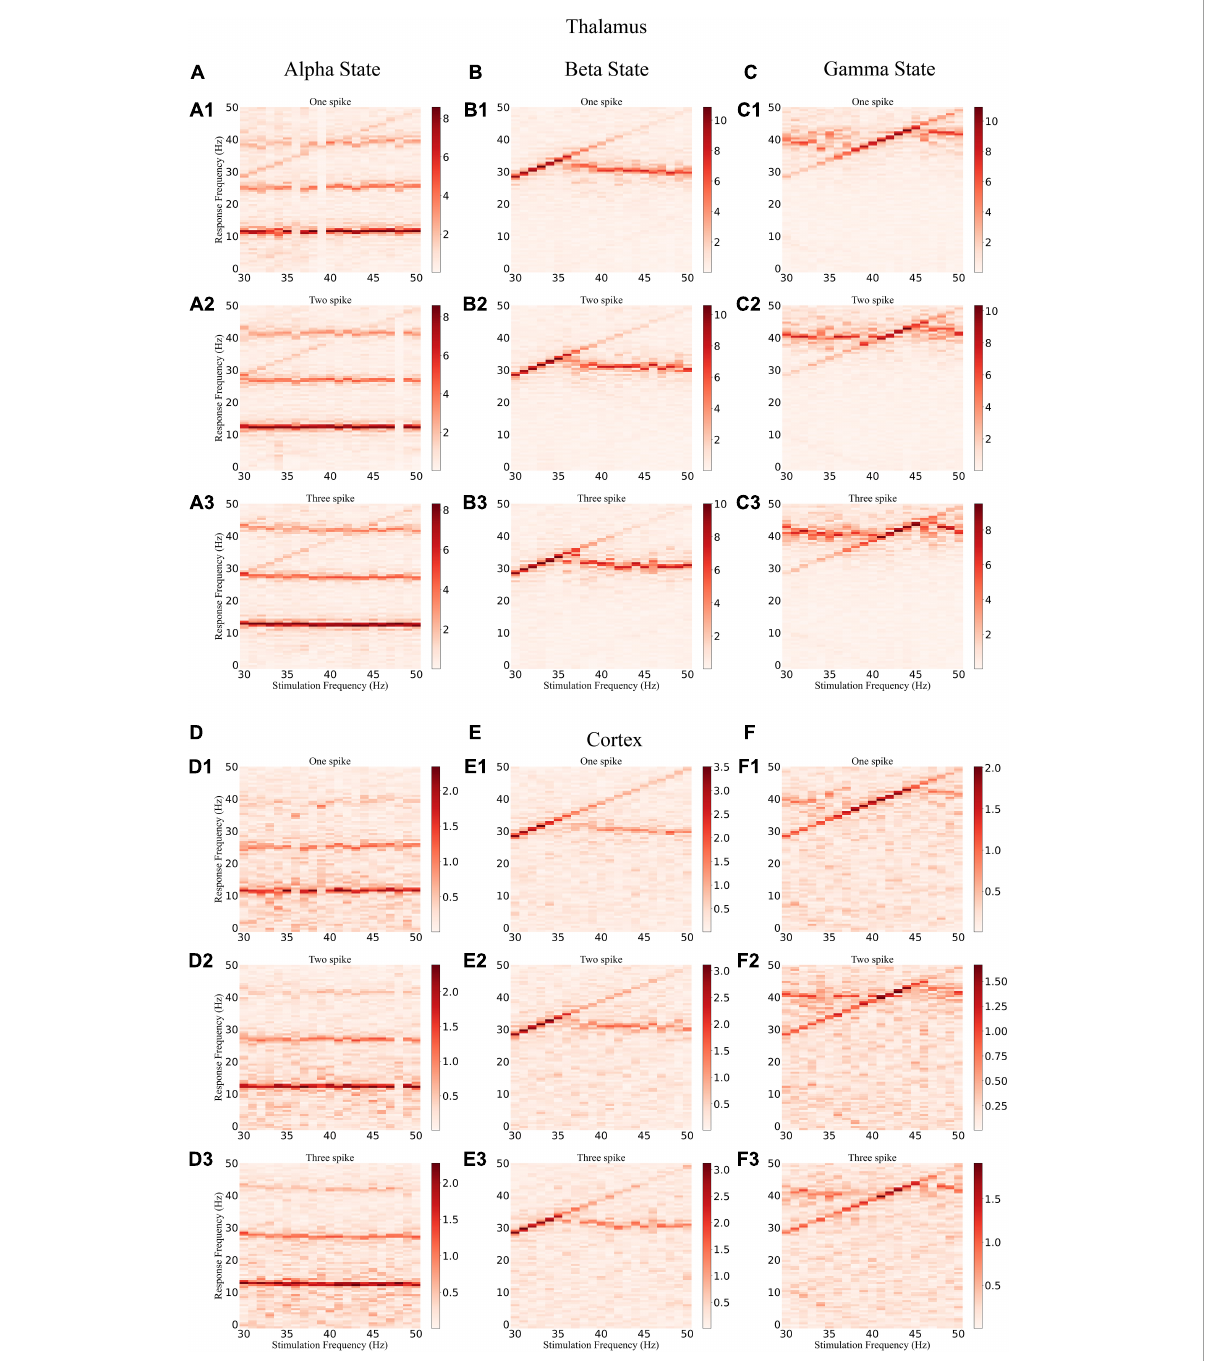
FIGURE6 Frequency spectrum heatmap of the sLFP. (A) The alpha oscillatory state of the thalamus under light flickers: (A1–A3) intensity of one, two, and three spikes, respectively. (B,C) The beta and gamma oscillatory states of the thalamus under light flickers, respectively. (D–F) The alpha, beta, and gamma oscillatory states under light flickers of the cortex, respectively.